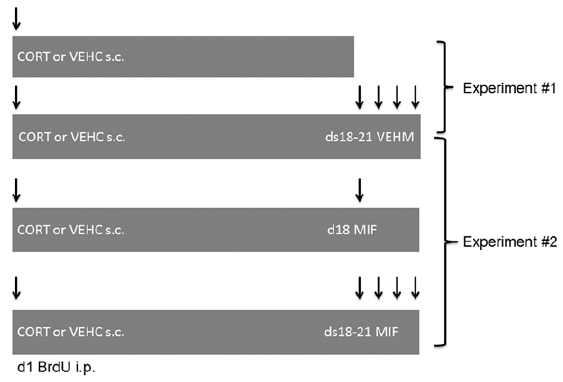
Figure 1. Schematic representation of experimental groups. In experiment # 1, we compared animals treated subcutaneously with corticosterone (CORT) or vehicle (VEHC) daily for 17 days with animals treated for 21 days; the latter groups also received the vehicle of mifepristone (VEHM) on days 18–21. In experiment # 2, the 21 ds CORT/ VEHC + ds 18–21 VEHM were used as statistical reference groups in a comparison with experimental groups receiving mifepristone on d18 only (21ds CORT + ds18 MIF and 21ds VEHC + ds18 MIF) or on 4 days from 18–21 (21ds CORT + ds18–21 MIF and 21ds VEHC + ds18–21 MIF). All animals were treated with BrdU on day 1 and sacrificed on the morning after the last treatment.